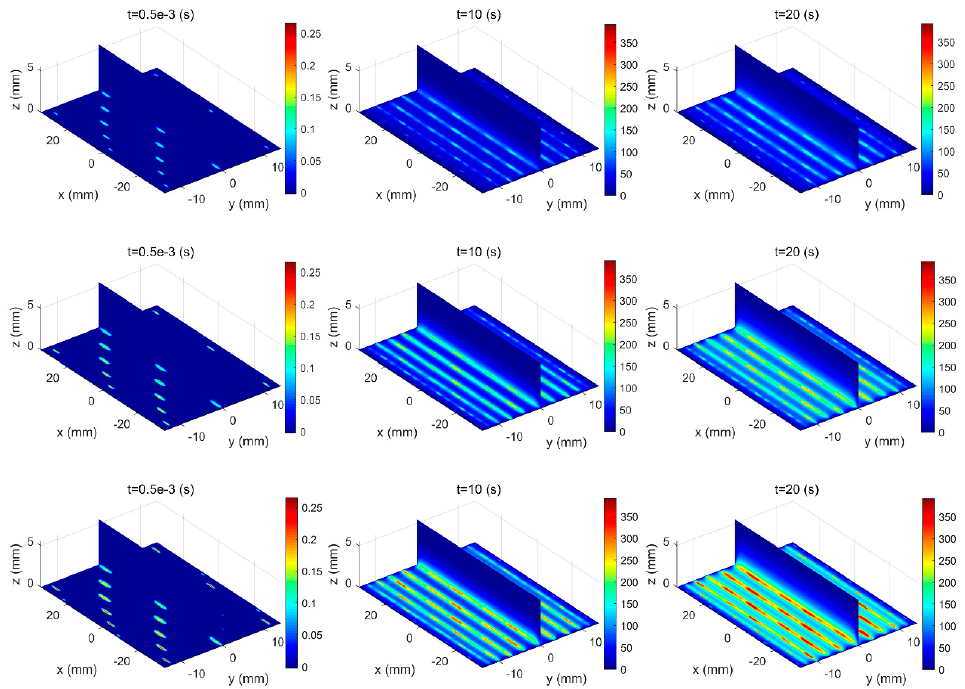
Figure 5. Temperature distributions (°C) on xy and xz planes at several instants for w = 1960 N ( top ), 3920 N ( middle ) and 5880 N ( bottom ), v = 5 m/s.